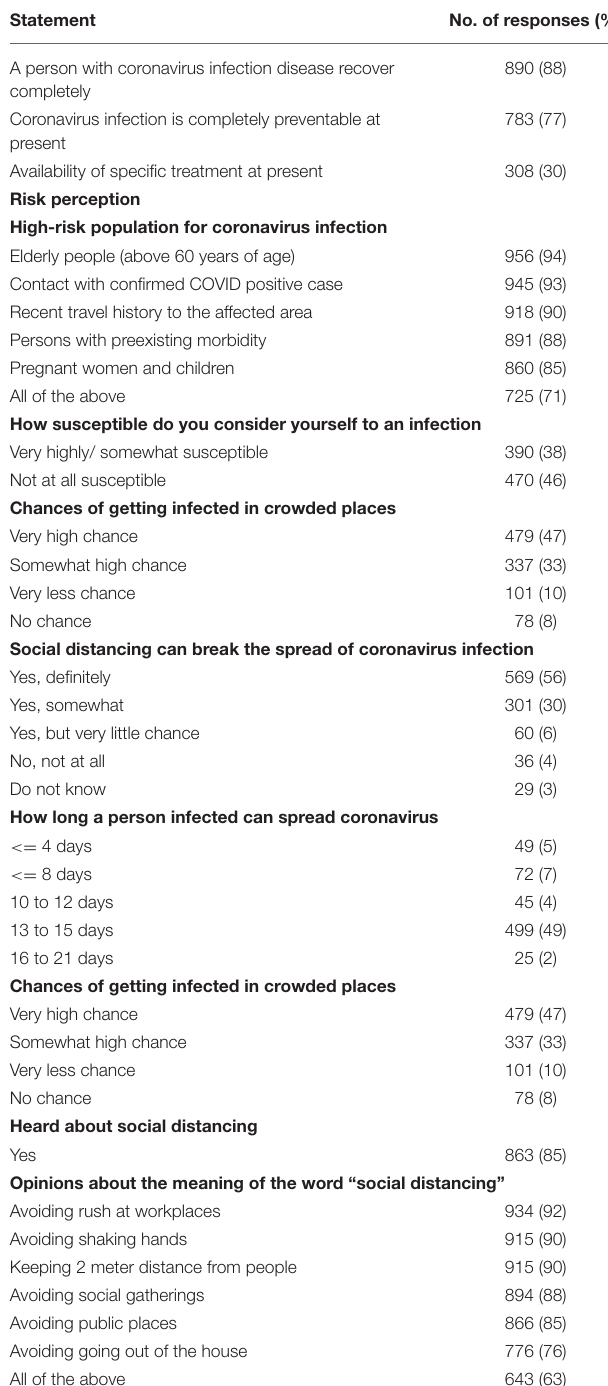
TABLE 3A | Participants knowledge and their level of awareness related to COVID- 19 infection.